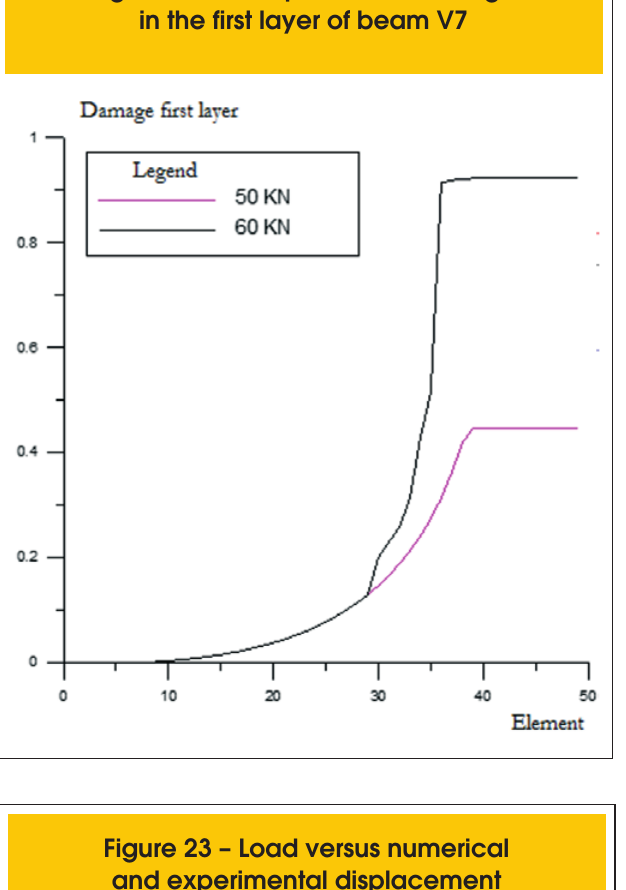
Figure 25 – Parametric identification through beam V7 with 0.5%